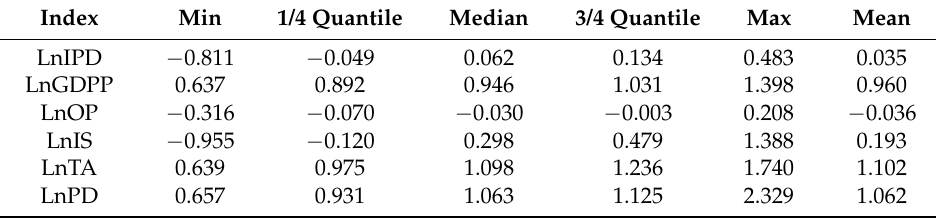
Table 4. The statistical description of all parameter estimates (Band width = 0.115).